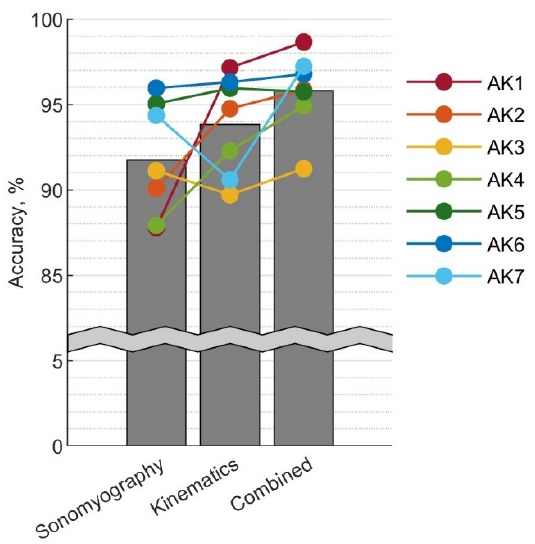
Figure 8. Classification accuracy when using sonomyogaphy data, kinematics data, or combined data from both sensors. The bars indicate the mean accuracy for the group, while individual subjects’ accuracies are shown in color. The grey waved line indicates a break in the